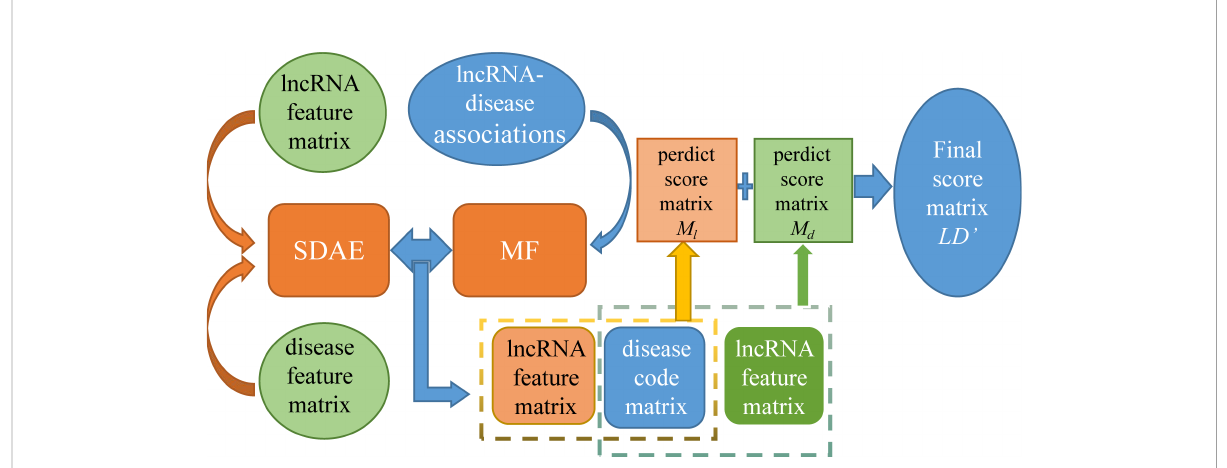
FIGURE 6 The fl owchart of LDICDL for lncRNA-disease associations based on collaborative deep